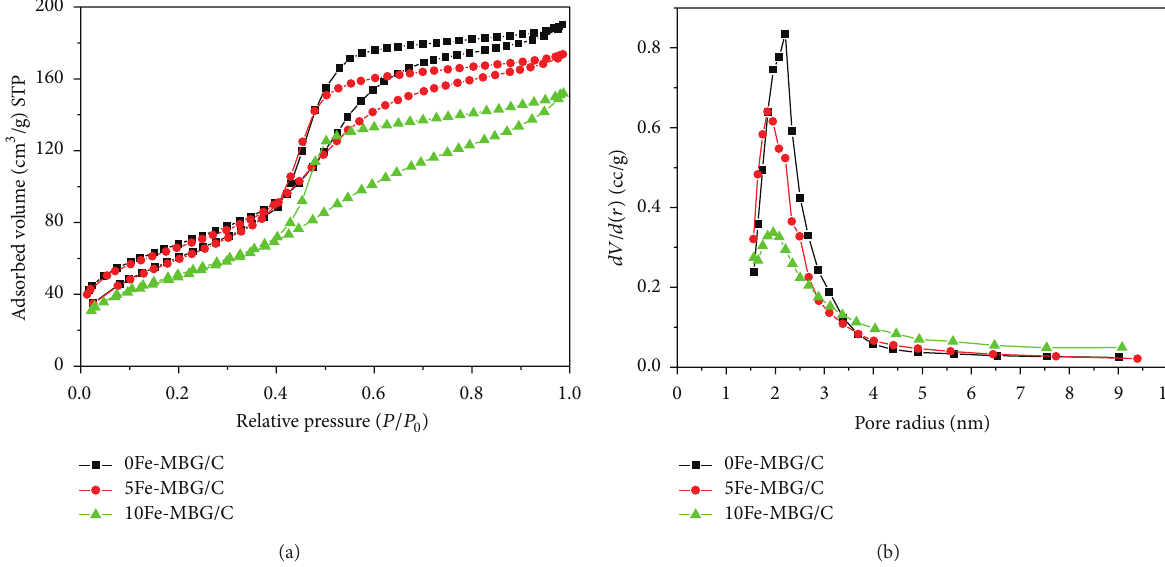
Figure 5: N 2 adsorption isotherms (a) and the corresponding pore size distributions (b) of different Fe-MBG/C composite scaffolds.